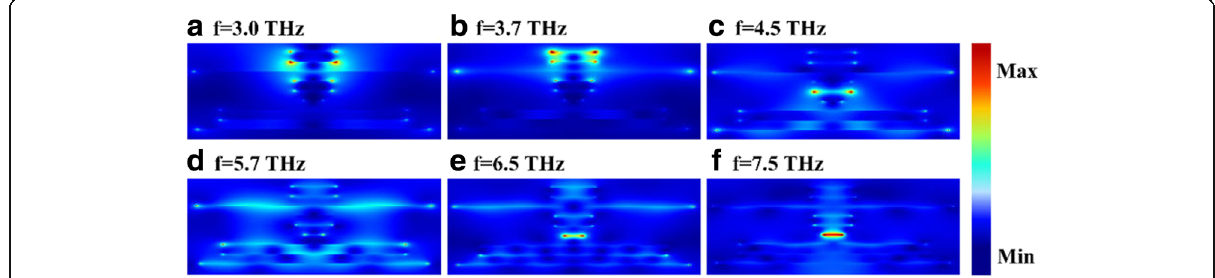
Fig. 6 a – f The distributions of the electric field amplitude (| E |) of the proposed absorber at different frequencies